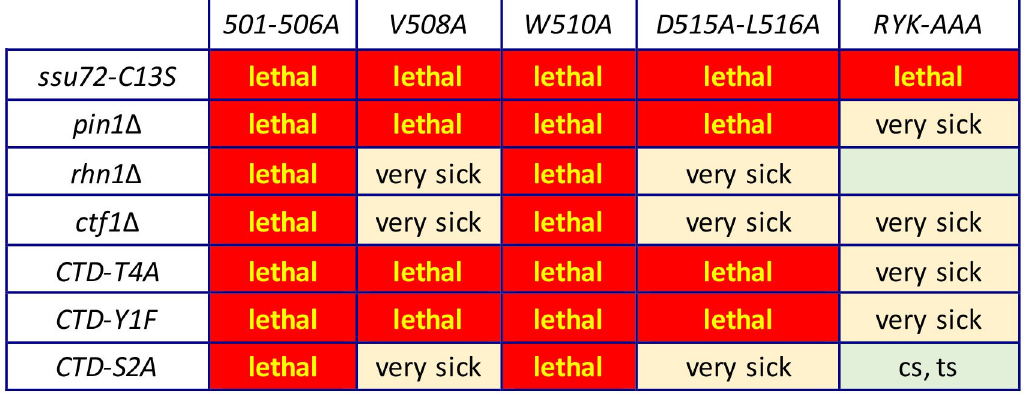
Fig 12. Effect of Dis2 and Swd22 binding-defective mutations on Ppn1 activity in vivo. ppn1 mutants specified in the top row were crossed to the mutant strains specified in the left-most column. Synthetically lethal pairs of alleles are highlighted in red boxes. The yellow boxes indicate severe synthetic growth defects (very sick). A viable double mutant without a synthetic defect is indicated by a plain green box. A viable double mutant that displayed temperature-sensitive ( ts ) or cold-sensitive ( cs ) defects is annotated as such in its green